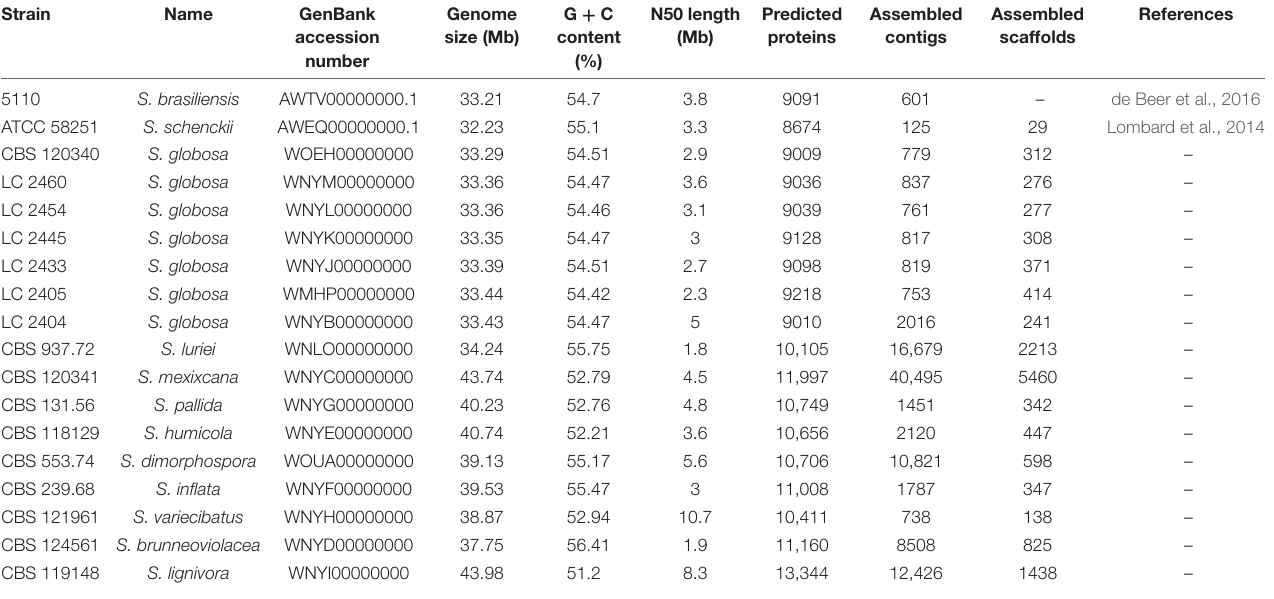
TABLE 2 | Genome statistics of Sporothrix